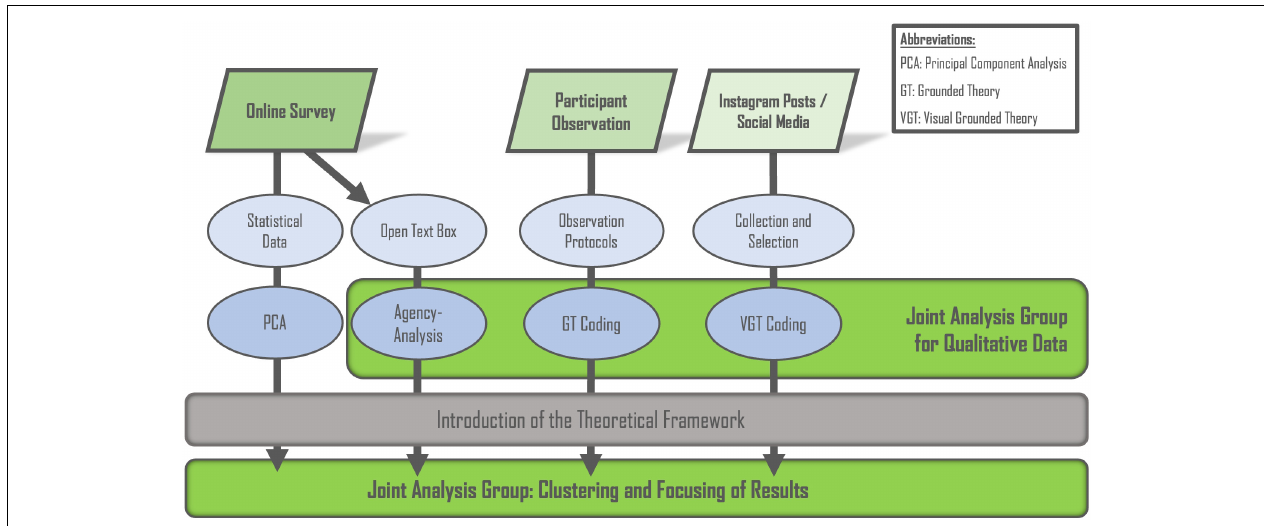
FIGURE 1 | Methodological